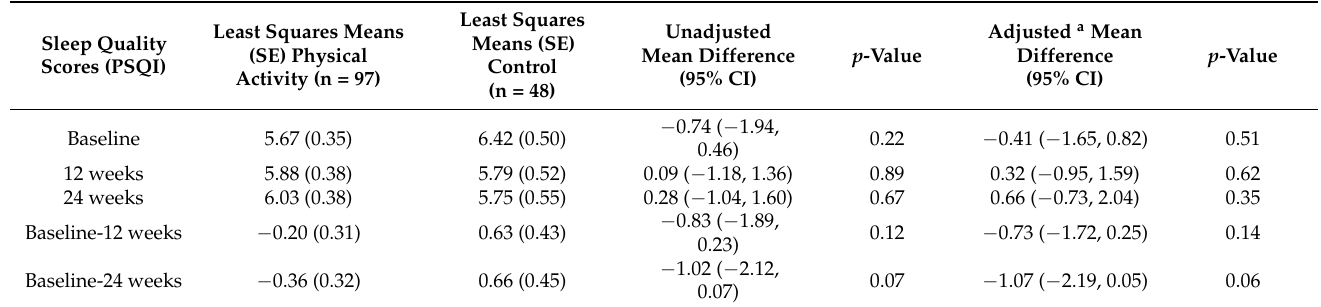
Table 3. Mixed Model Estimates of Sleep Quality Among Older Stroke